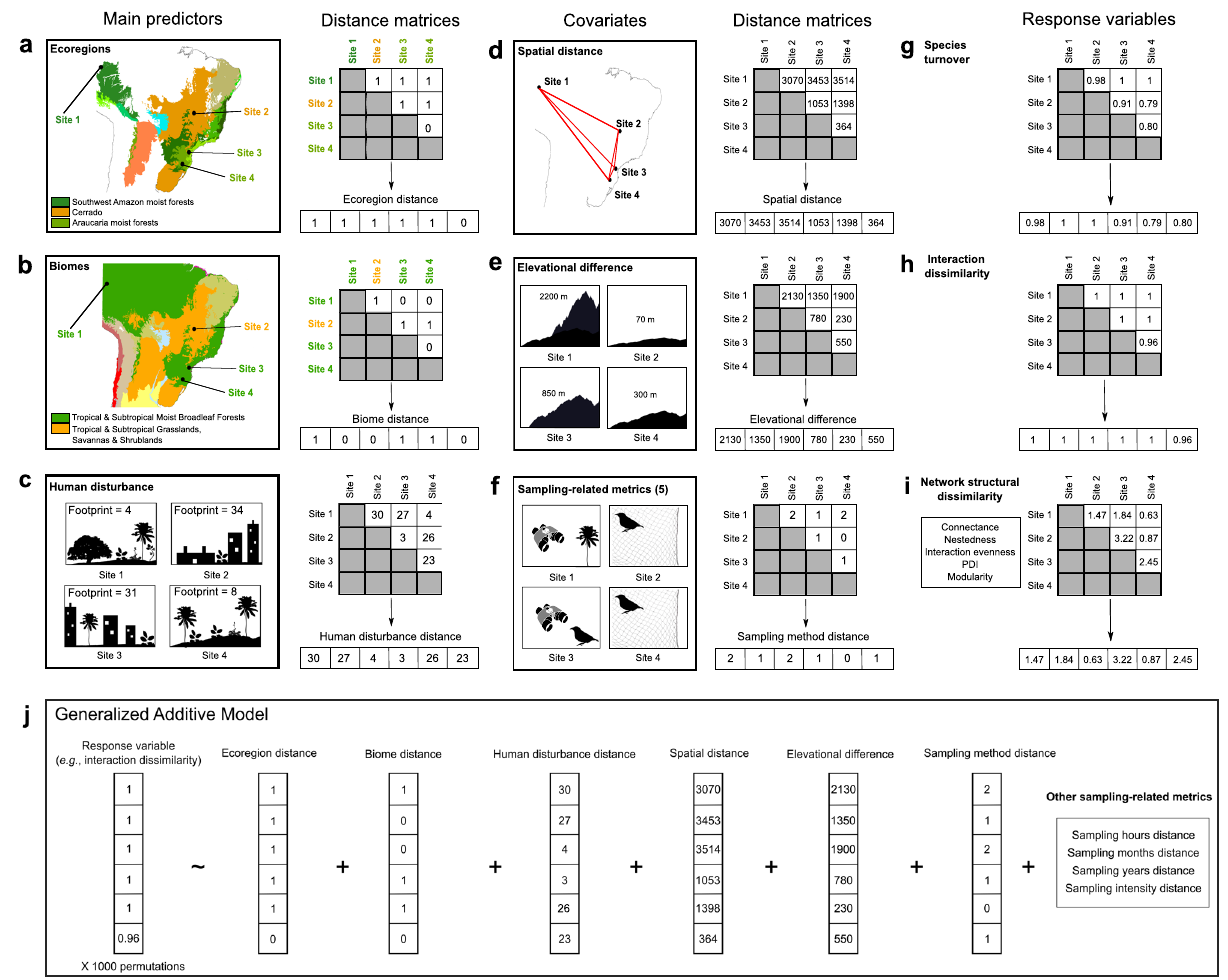
Fig. 1 | Our approach for evaluating the multiple predictors of network dis- similarity atlarge spatial scales. We used several distancematrices ( N × N , where N is the number of local networks in our dataset) as variables in the statistical models. a , b Maps show examples of ecoregions and biomes (colors of shaded areas)representedinourdataset.Pointsindicatethelocationsoffournetworksites usedtoillustratehowwegeneratedourdistancematrices(seeFig.2tovisualizethe locations of all network sites in our dataset). Ecoregion and biome distance matrices were generated using both a binary (shown in the fi gure) and a quanti- tative approach (generated by measuring the environmental dissimilarity between ecoregions/biomes;see “ Methods ” ).Becauseecoregionsarenestedwithinbiomes, networksiteslocatedwithinthesameecoregionarealwayswithinthesamebiome, but the opposite isnotnecessarily true; see, for example, the comparison between network site 1 and network site 3, which involves two ecoregions (Southwest Amazonmoist forest and Araucaria moist forest) from the samebiome(Tropical& SubtropicalMoistBroadleafForests). c Thehumandisturbancedistancematrixwas generated by calculating the absolute difference between local-scale human